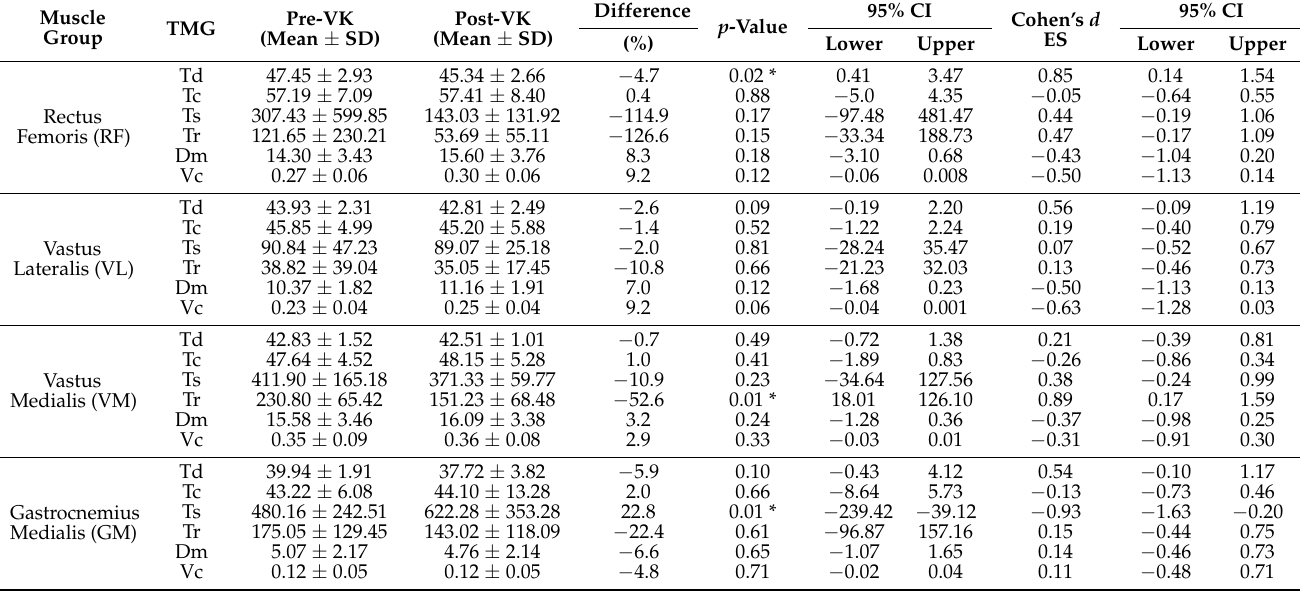
Table 2. Peripheral fatigue before and after the VK trail running race for both legs.